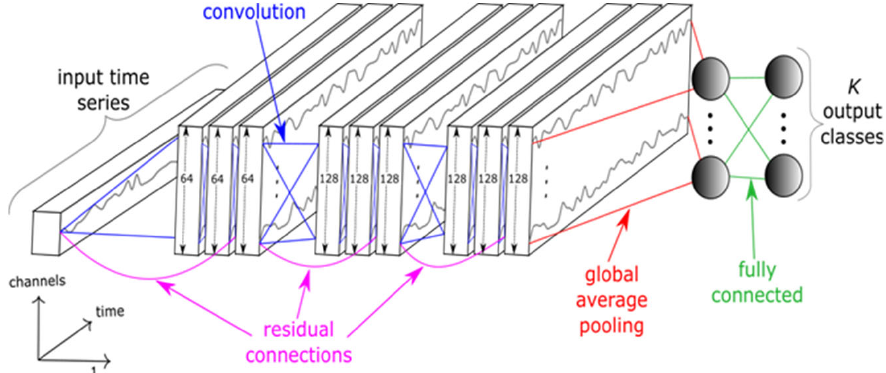
Figure 1. One ‐ dimensional CNN (ResNet) structure [26]. Figure 1. One-dimensional CNN (ResNet) structure